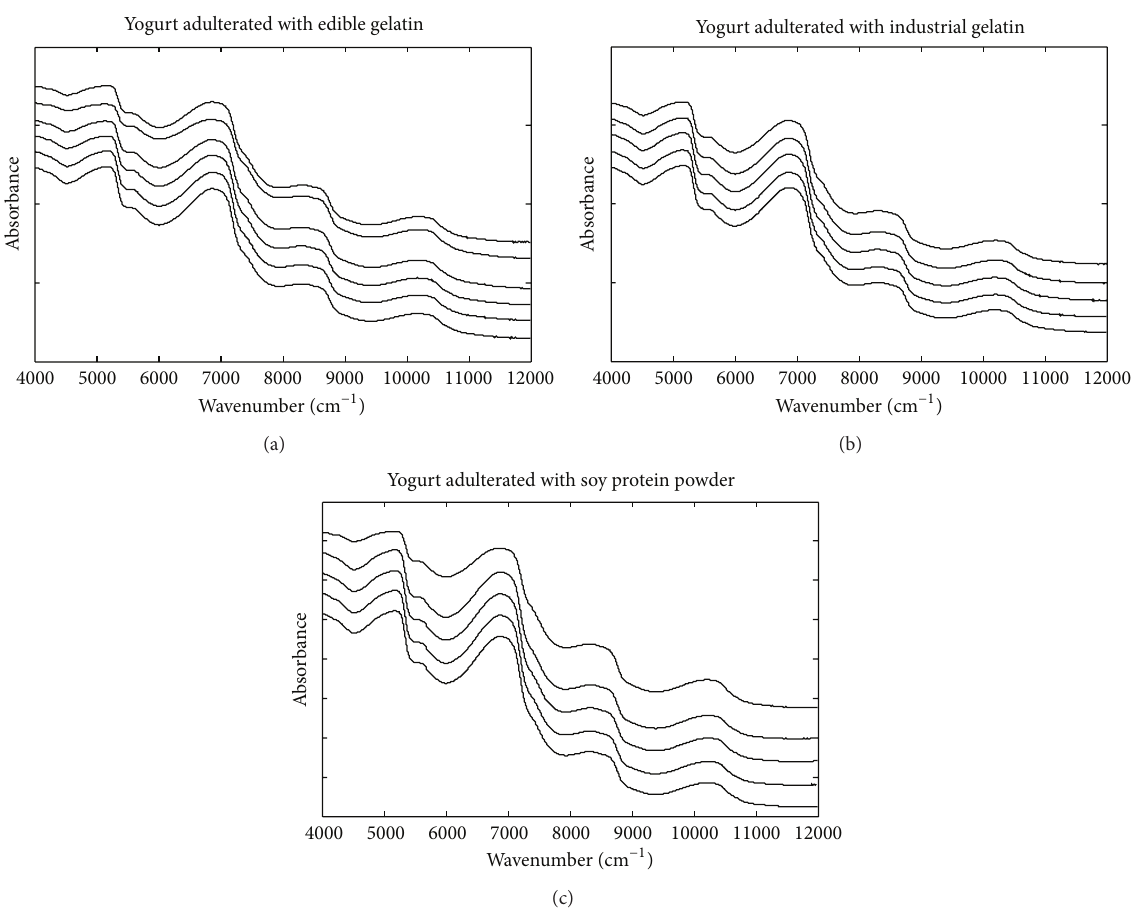
Figure 2: Average NIR spectra of yogurt objects adulterated with different levels of edible gelatin, industrial gelatin, and soy protein powder. A shift was added to differentiate doping levels and a larger shift corresponds to a higher doping